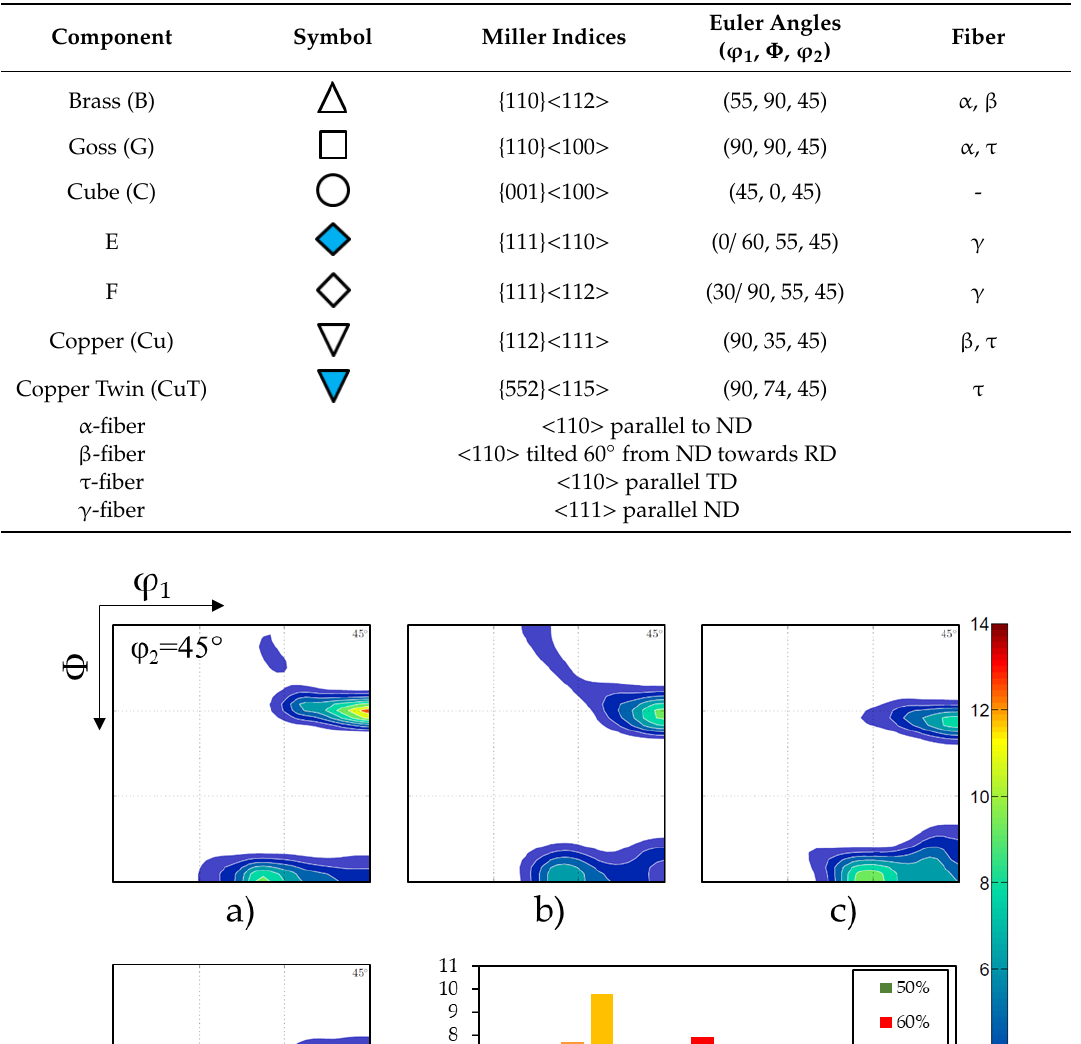
Table 3. Definition of texture components illustrated in Figures 4 and 5.